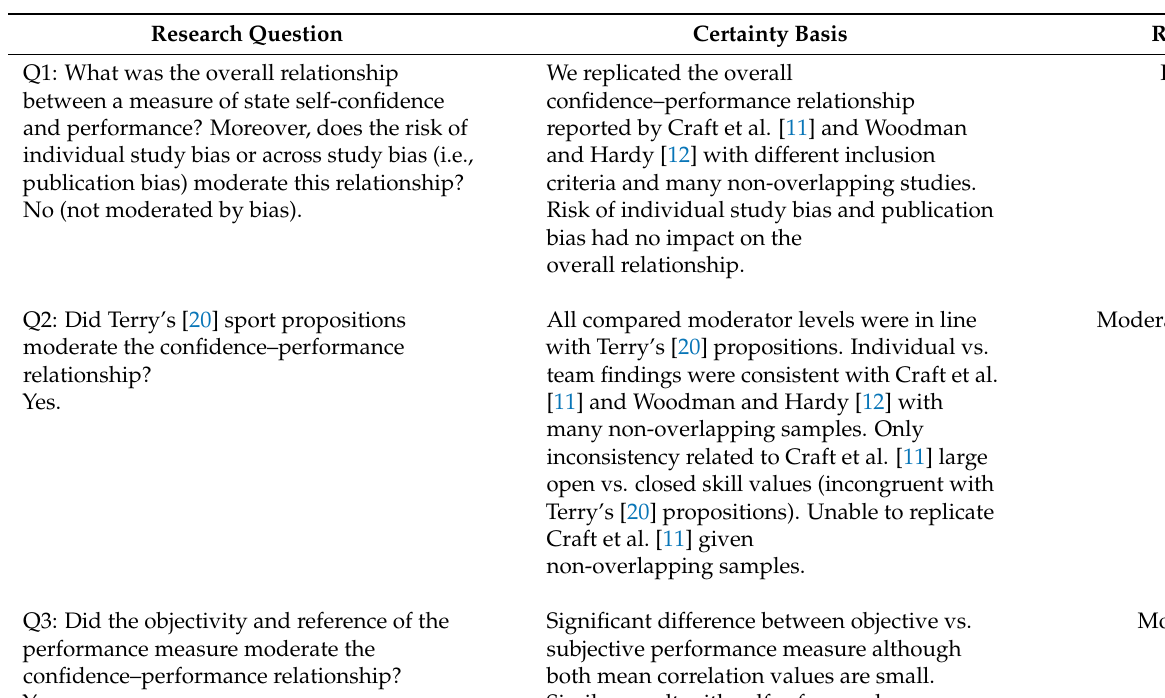
Table 5. Certainty of Results by Research